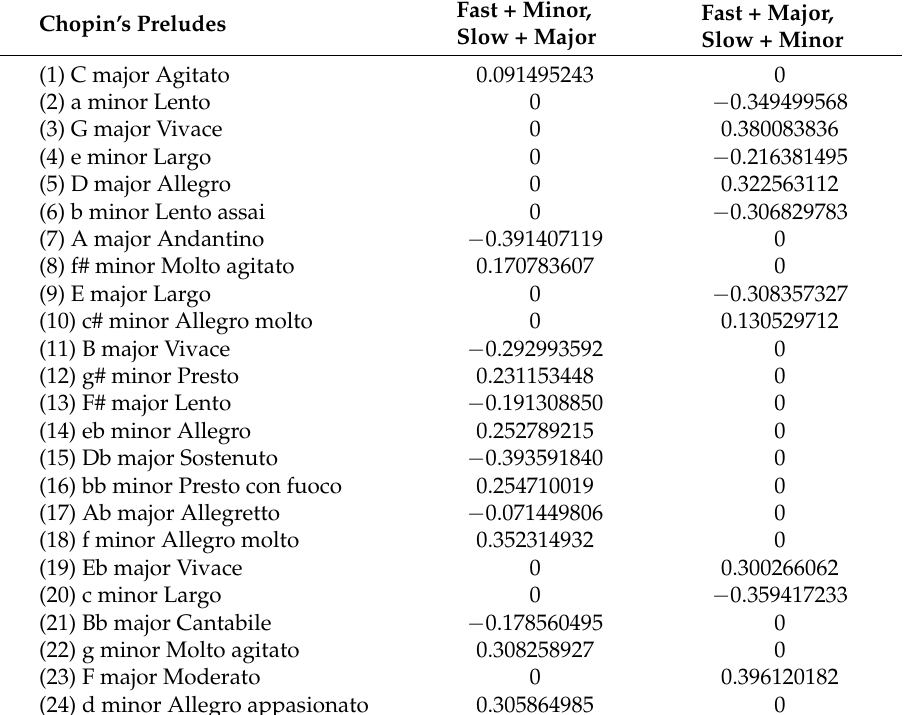
Table 21. Loading matrix A obtained with the DisjointTuckerALS algorithm for Chopin’s data. Chopin’s